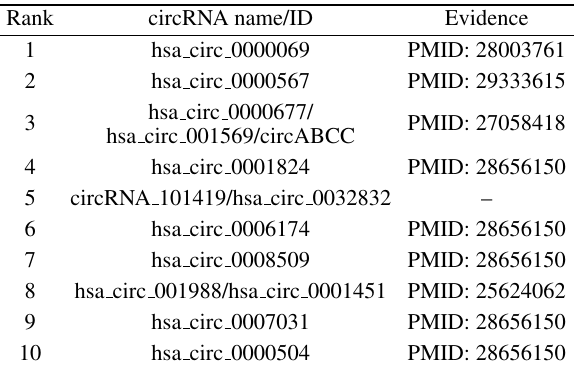
Table 1 Top 10 new colorectal cancer-related candidate